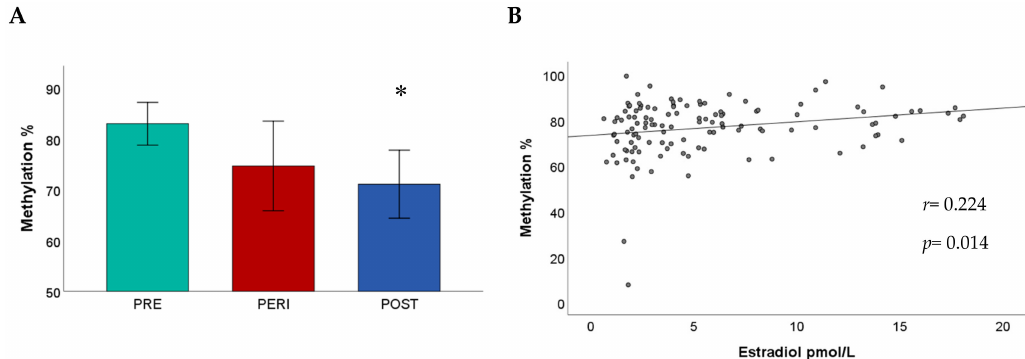
Figure 1. ( A ) Cytosine-phosphate-guanine island (CpGI) shore methylation at CpG9 in menopausal groups.